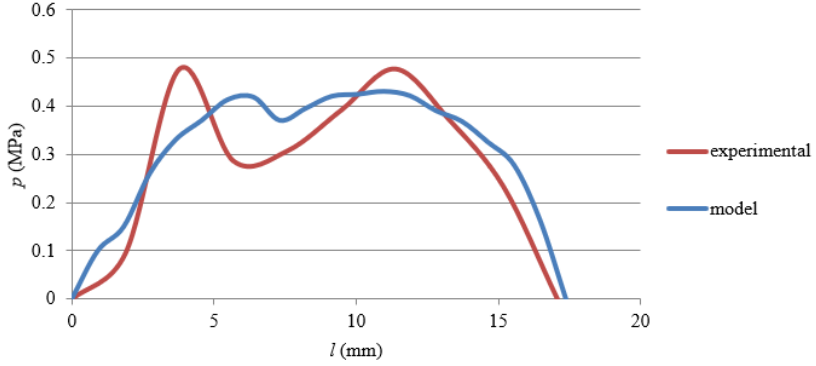
Figure 14. Surface pressure values as a function of distance for dropping an apple from a height of 30 mm on a concrete substrate.